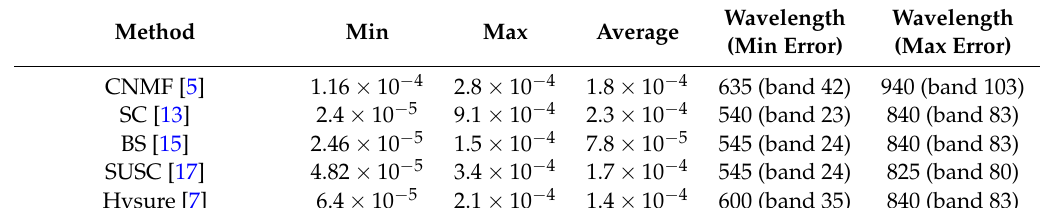
Table 2. Average squared error for the Pavia dataset.